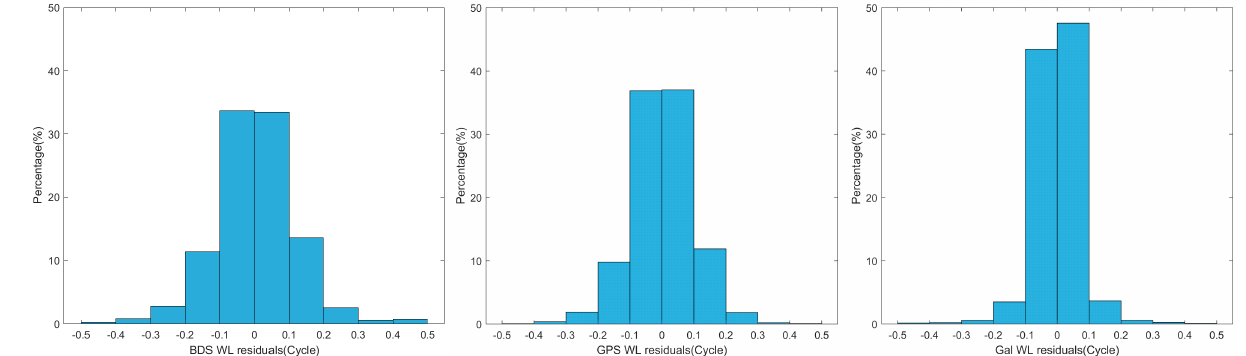
Figure 6. The WL residual distributions of the BDS-3, GPS, and Galileo on DOY 301, 2021.